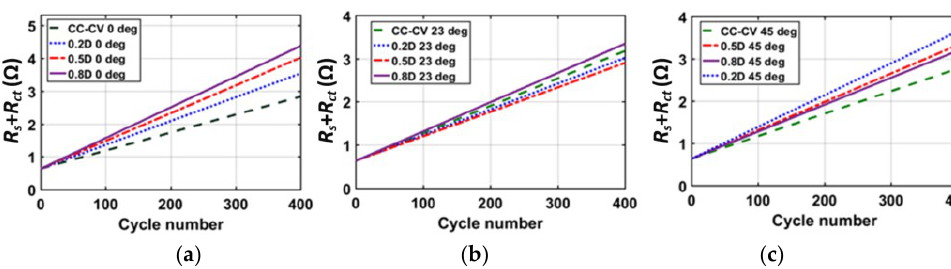
Figure 12. Trend of R s , and R ct vs charge/discharge cycles, ( a ) at 0 o C; ( b ) at 23 o C; ( c ) at 45 o C.